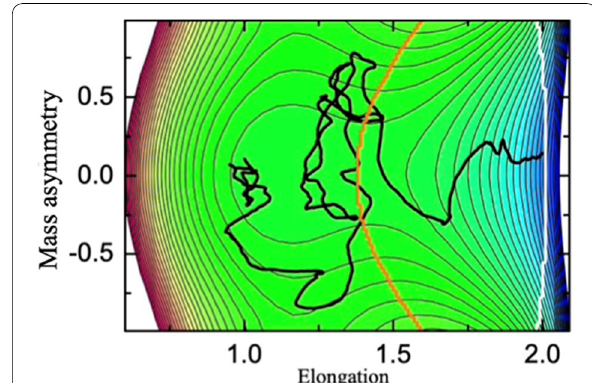
Fig. 4 A typical fissioning Langevin trajectory on the LDM potential energy surface of 224 Th calculated for compound nuclear angular momentum and temperature of 60 ℏ and 2MeV, respectively. The orange and white lines are the saddle ridge and scission line, respectively. The figure is adapted from